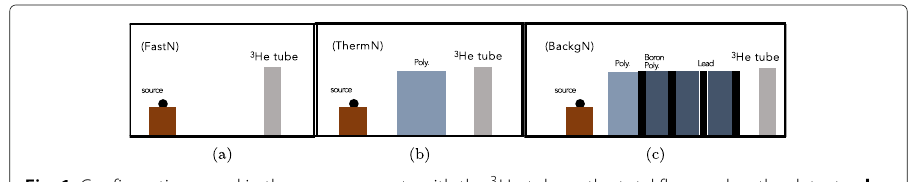
Fig. 1 Configurations used in the measurements with the 3 He-tube: a the total flux reaches the detector, b flux thermalized through a polyethylene brick, c flux highly reduced through polyethylene, borated polyethylene and lead bricks, in order to perform a background measurement with the